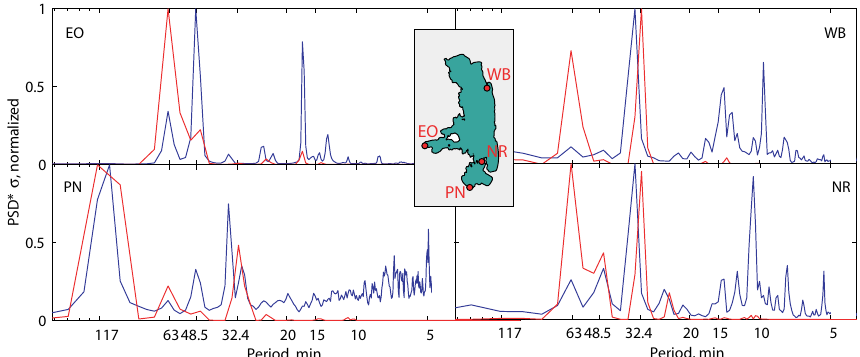
Figure 9. Spectra of measured (blue) vs. modeled (red) free-surface oscillations at four different locations in Flathead Lake. The inlet shows the positions of the corresponding measurement